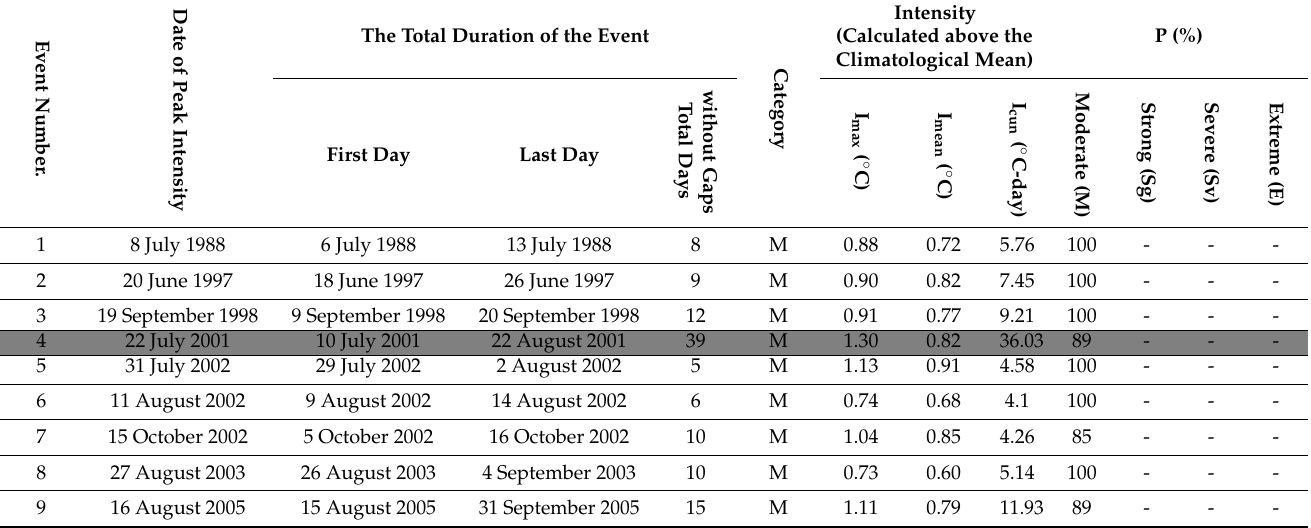
E v e n m b e r